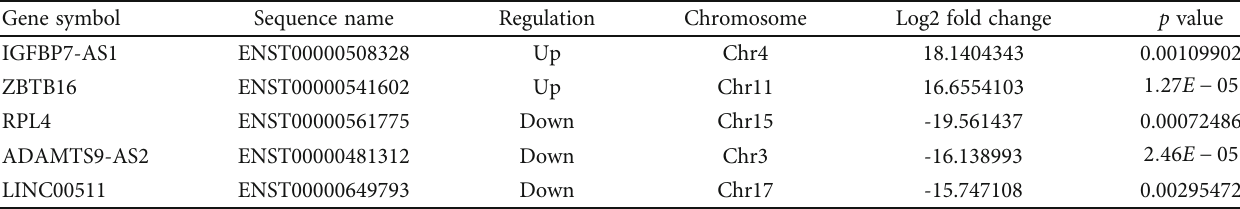
Table 2: Characteristics of the top fi ve di ff erently expressed lncRNAs on day 7.